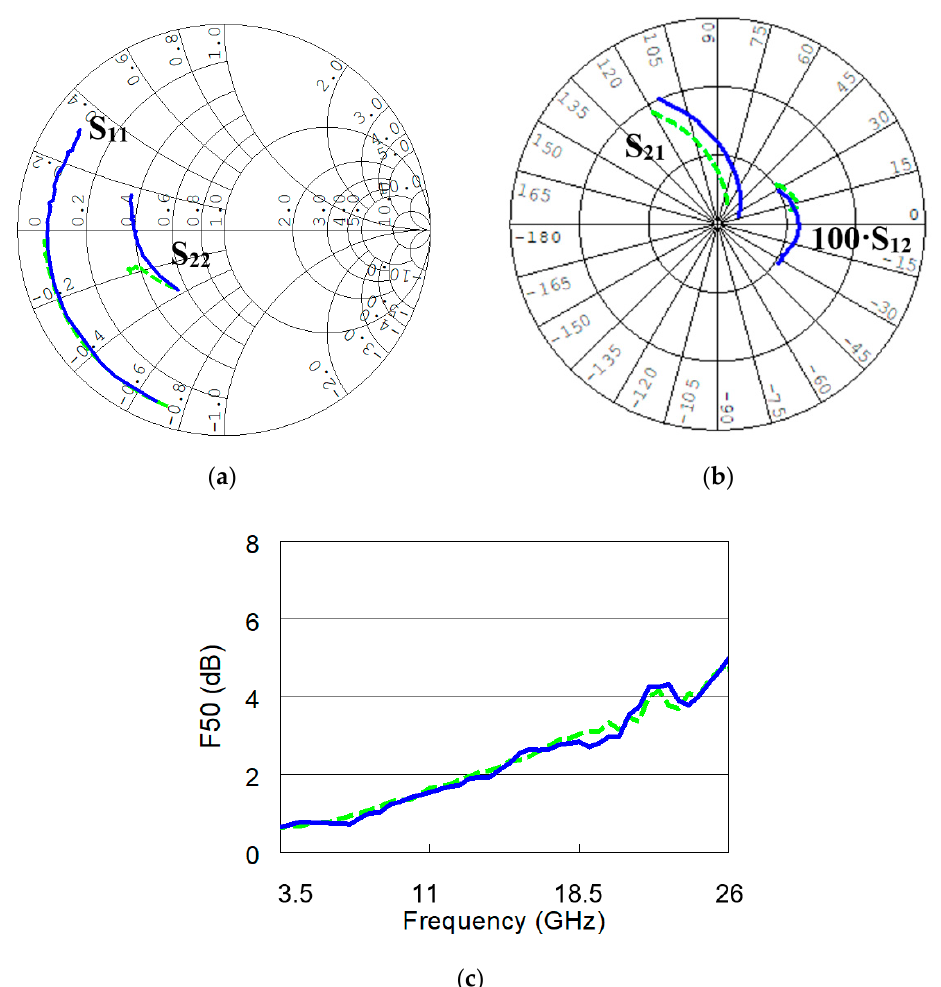
Figure 9. Scattering parameters measured by NRL (green dashed line) and UniME (blue solid line) for a HEMT with gate width of 10 × 60 μ m (3.5–26 GHz). ( a ) S 11 and S 22 , ( b ) S 21 and 100 · S 12 , ( c ) F 50 . V DS = 2 V and I DS = 120 mA.